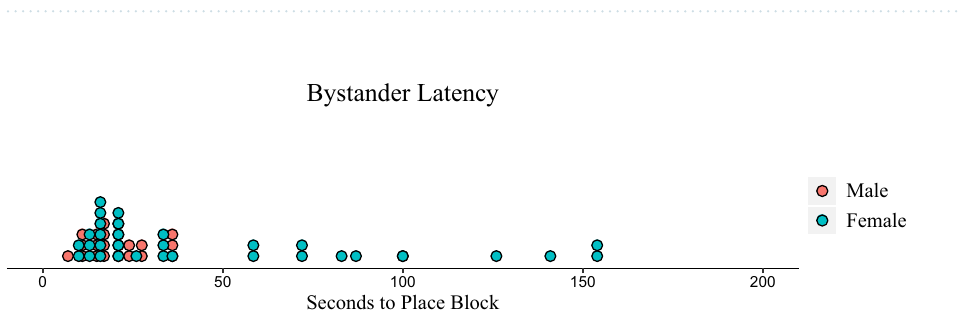
Figure 1. Latency (seconds) following the accident to begin building the tower for female and male victims.